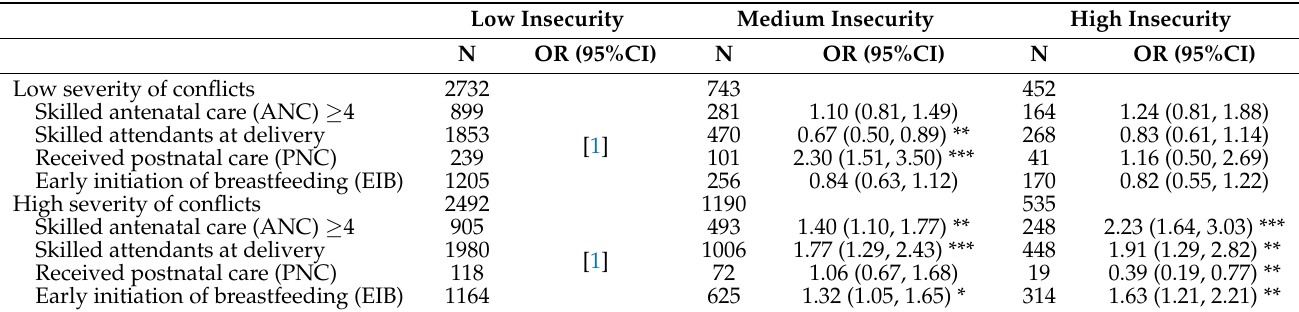
Table 6. Associations between self-reported insecurity with maternal health-seeking behaviours, stratified by the severity of conflicts †. Low Insecurity Medium Insecurity High